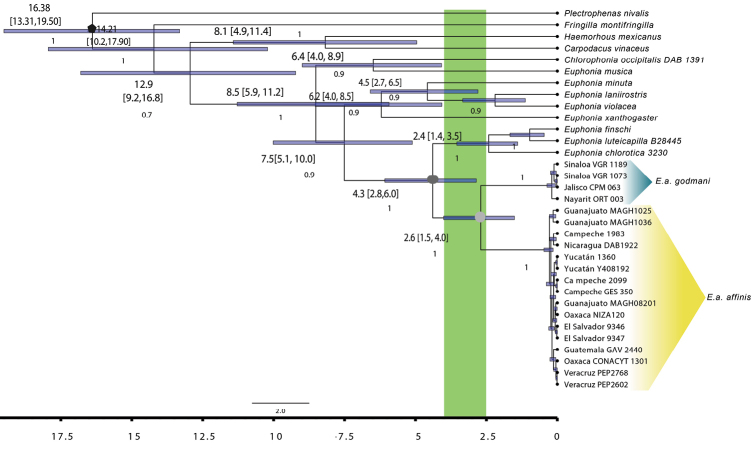
Ultrametric phylogenetic tree obtained by BEAST using ND2, ODC, and GAPDH concatenated matrix. The rhombus node represents the calibration point 17.1104 My with a 95% HPD of (14.7743, 19.6278) (see methods), dark gray circle node represents the E.
affinis origin and light gray circle node represents the break between E.
a.
godmani and E.
a.
affinis. Above the branch the diversification dates (My) and in brackets the 95% HPD. Below branch the number indicated the posterior probability. The green area corresponds to the period when lowland dry forests had a greater expansion in Western Mexico.